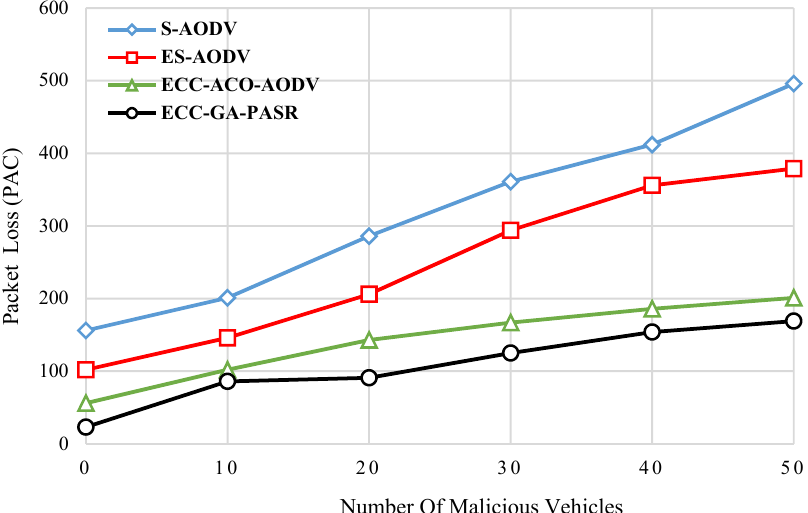
Figure 20. Packet Loss Calculation based on number of malicious vehicles.